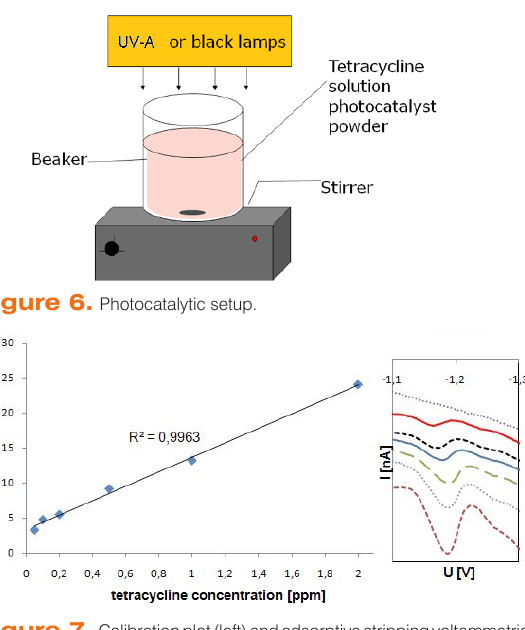
Figure 7. Calibration plot (left) and adsorptive stripping voltammetric response (right) of 0, 0.05, 0.1, 0.2, 0.5, 1 and 2 ppm aqueous tetracycline solution (from top to bottom) in 25 mM boric acid (pH 5.5), deposition time: 180 s, deposition potential: 600 mV.